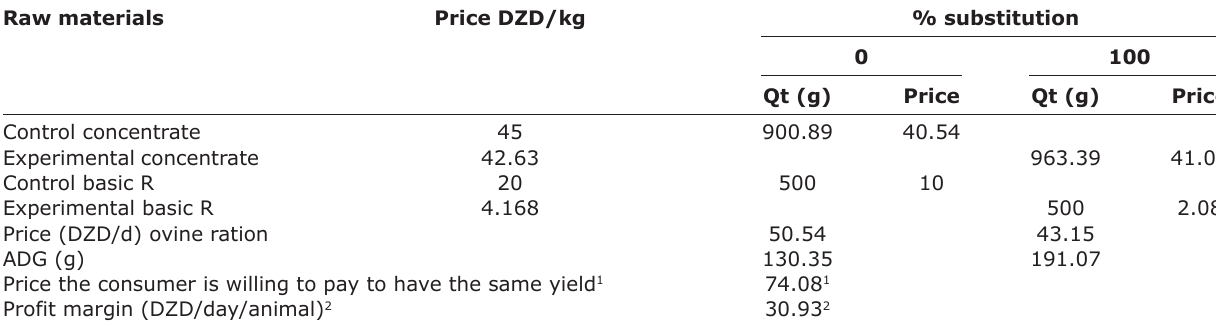
Table-8: Economic cost.